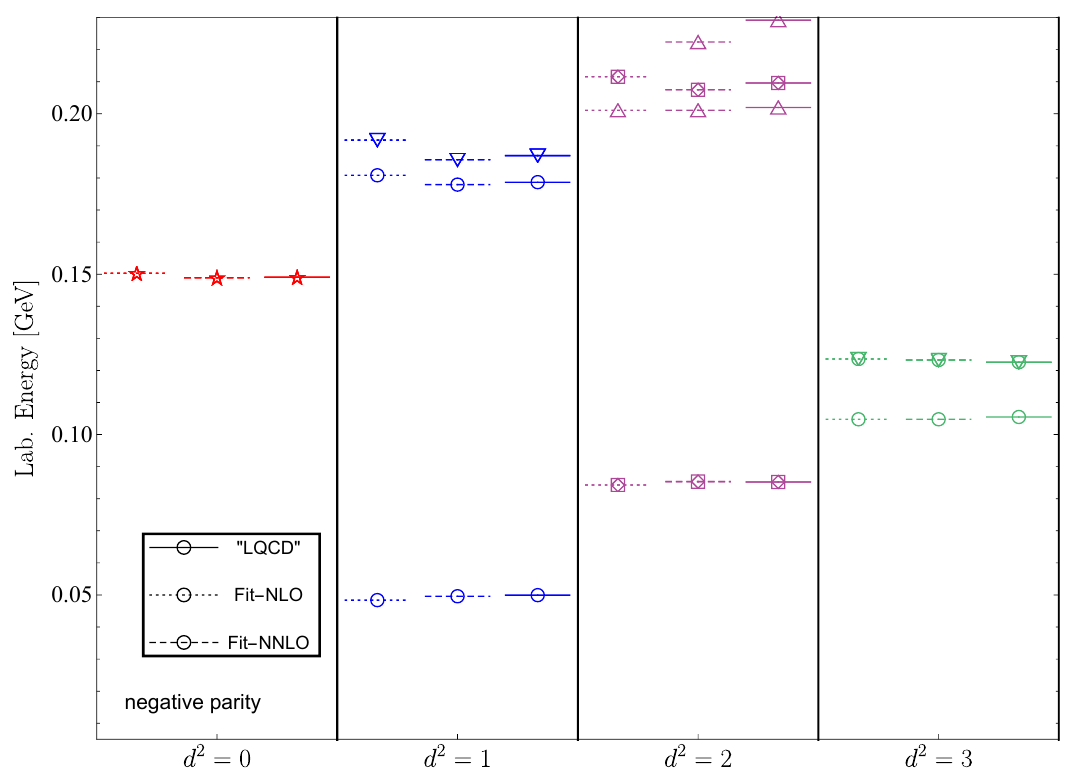
Figure 9 . Comparison of the synthetic lattice energy levels with negative parity in the box with L = 5 fm and those from the EFT determined by fitting. The marker shapes represent the irreps, which are the same as those in figure